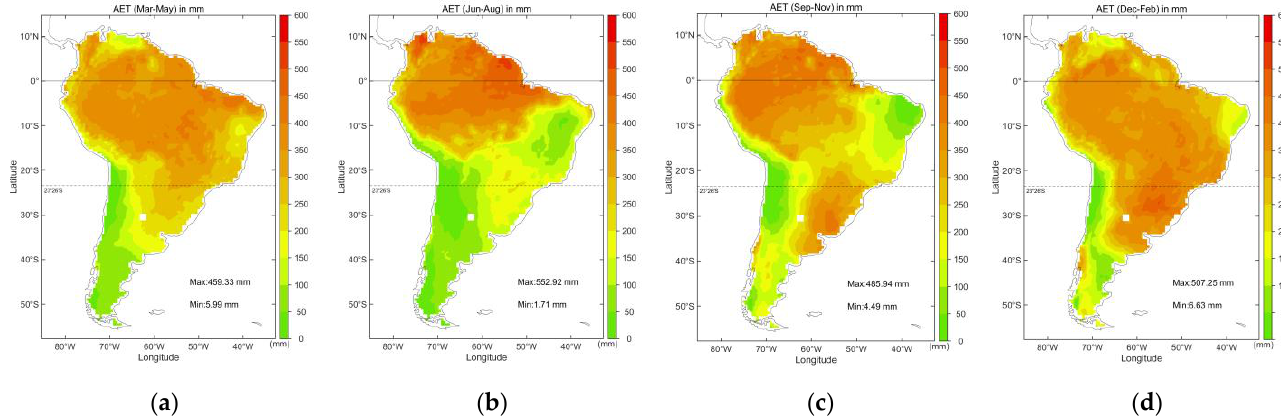
Figure 5. Spatial distribution map of average AET in four seasons. ( a ) Mar-May, ( b ) Jun-Aug, ( c ) Sep-Nov, ( d ) Dec-Feb.